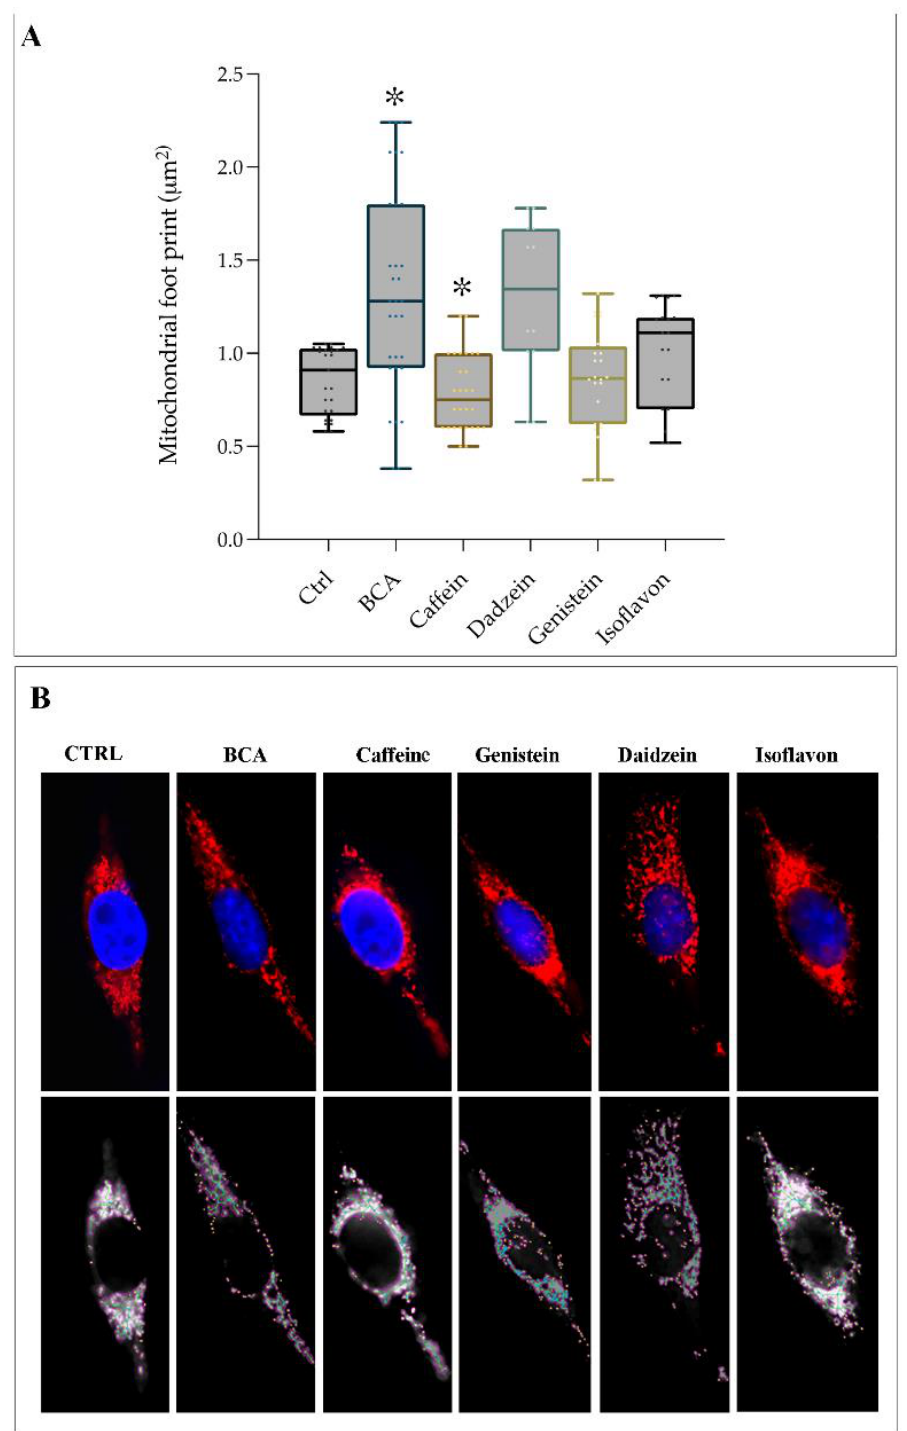
Figure 3. Results from mitochondrial network analysis in hGL5. ( A ) Summary statistics for all cells. Box plots show median (horizontal lines), first to third quartile (box), and the most extreme values within 1.5 times the interquartile range (vertical lines). Differences between control and TAS2Rs agonists-treated cells were statistically evaluated. * p < 0.05). ( B ) Mitochondrial footprint (red) of cells exposed to different compounds. Nuclei were DAPI-stained (blue). CTRL = untreated cell (control). Magnification: 630 × . Staining pictures are representative of five independent